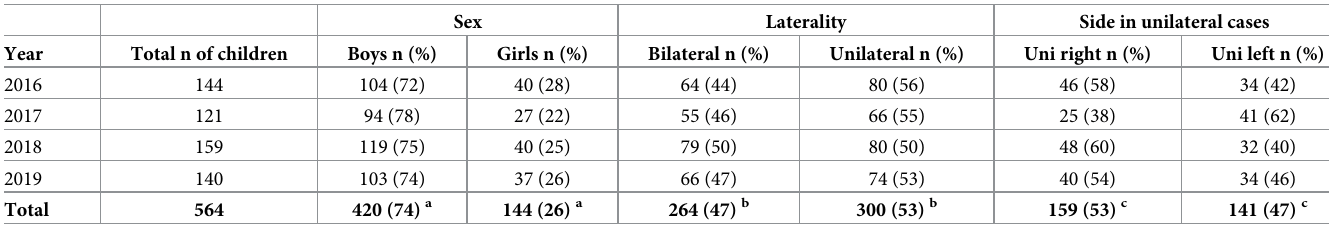
The 48 children (with a total of 77 clubfeet) with non-isolated clubfoot were reported in com- bination with Arthrogryposis multiplex congenita (Q74.3), n = 8; Spina bifida (Q05.9), n = 5; congenital malformation syndromes predominantly involving limbs (Q87.2), n = 18; neuro- logical diseases (not specified), n = 7; and other (not specified), n = 10. For one child, the dis- ease was not classified. Of the 48 children, 52% were boys and 60% had bilateral involvement. Table 2. Description of children with isolated